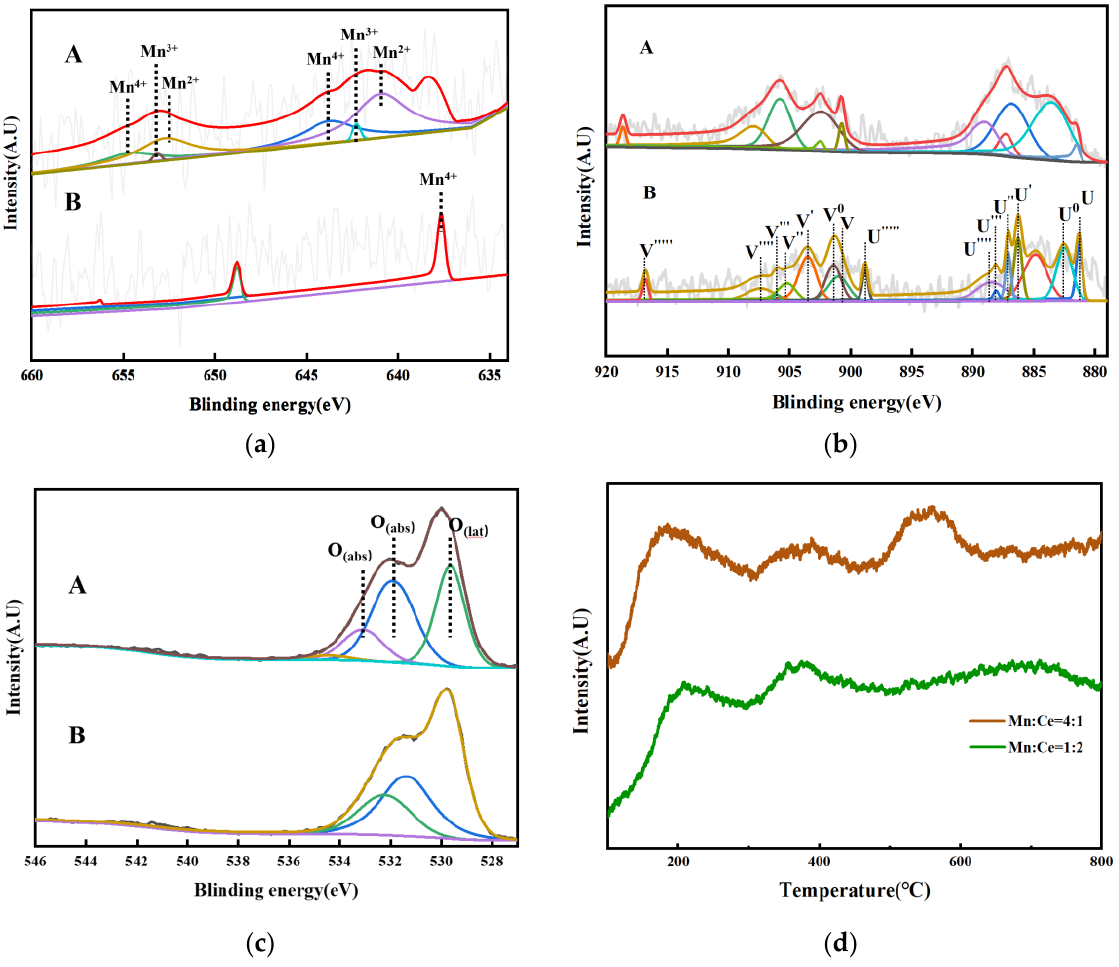
Figure 6. ( a ) XPS spectra of Mn 2p: A. Mn:Ce = 4:1; B. Mn:Ce = 1:2; ( b ) XPS spectra of Ce 3d: A. Mn:Ce = 4:1; B. Mn:Ce = 1:2; ( c ) XPS spectra of O 1 s: A. Mn:Ce = 4:1; B. Mn:Ce = 1:2; ( d ) O 2 -TPD profile of Mn-Ce/Al 2 O 3 /TiO 2 catalysts (Mn:Ce = 4:1, Mn:Ce =